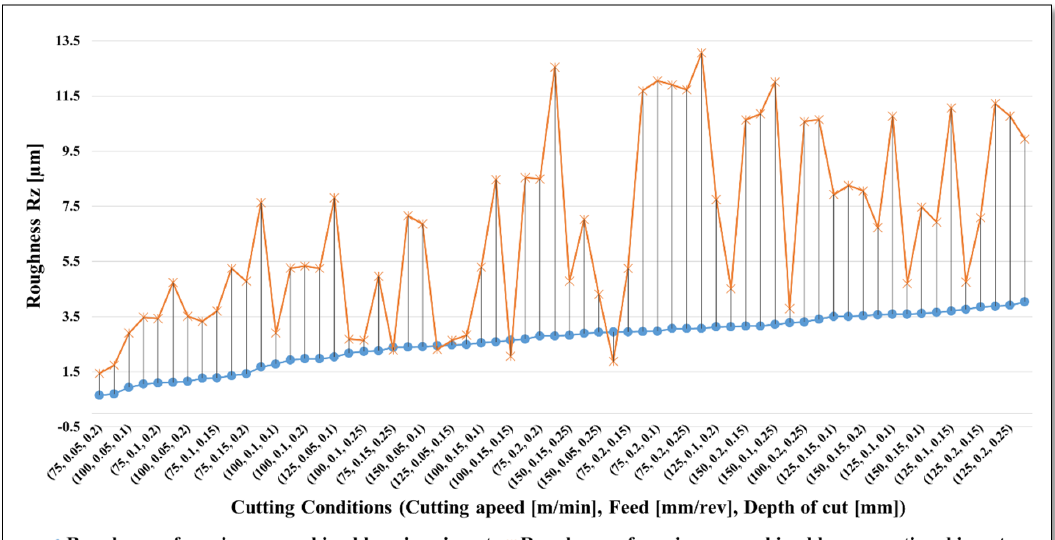
Figure 6. Resultant average roughness (Rz µm) for AISI 4340 specimens machined by wiper and conventional inserts.